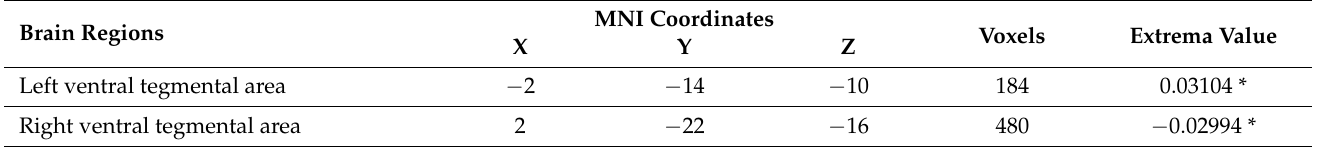
Table 3. Coordinates of the maxima in the activated brain regions associated with passionate love. Brain Regions